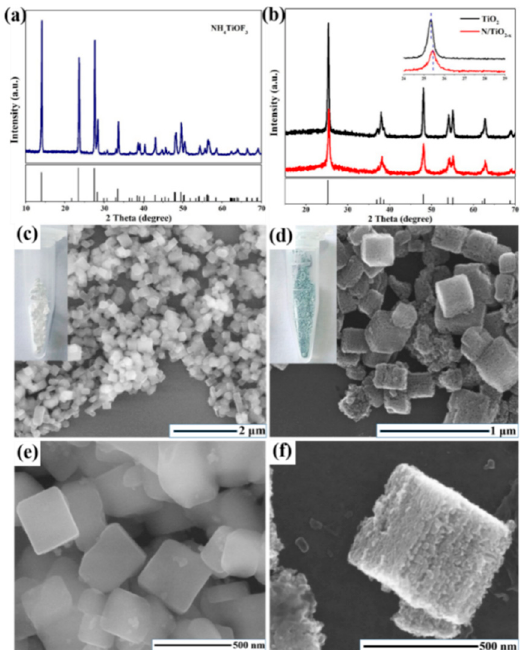
Figure 19. Schematic representation of the synthesis of TiO x nanosheets. X-ray powder diffraction (XRD) pattern of ( a ) NH 4 TiOF 3 and ( b ) N/TiO 2 − x . SEM images of ( c , e ) NH 4 TiOF 3 and ( d , f ) N/TiO 2 − x [108]. Copyright 2019 The Royal Society of Chemistry.